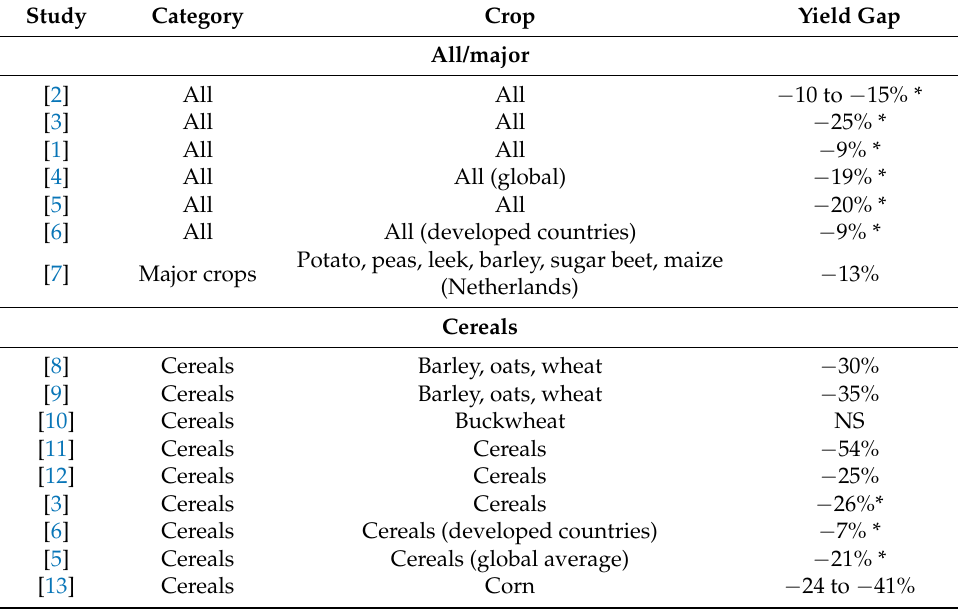
Table 1. Yield gaps by category and crop. Yield gaps (representing all plots and years of the respective study) vary by category of crop under consideration. * denotes a